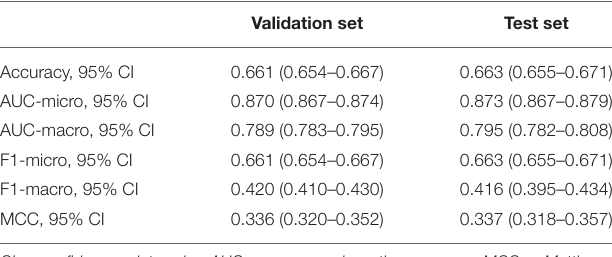
TABLE 3 | Performance of the validation set and test set under the 10-fold cross-validation test of the XGBoost model. Validation set